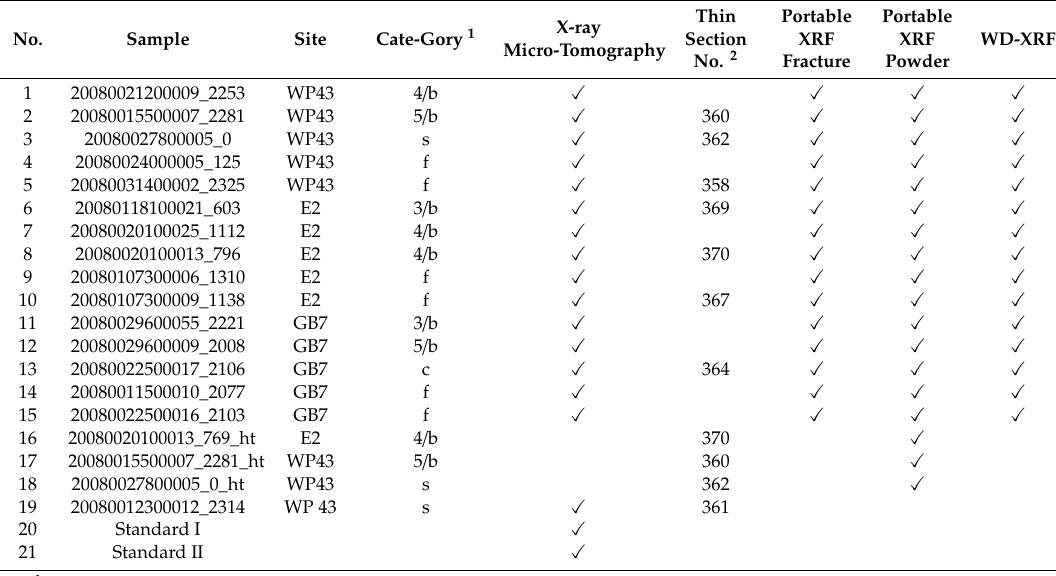
Table 1. Ceramic samples of this study and allocation to the selected megalithic tombs Emmeln 2 (E2), Groß Berßen 7 (GB7) and Werpeloh 43 (WP43) of the district of Emsland (Lower Saxony, Germany), including information about the samples and employed analytical